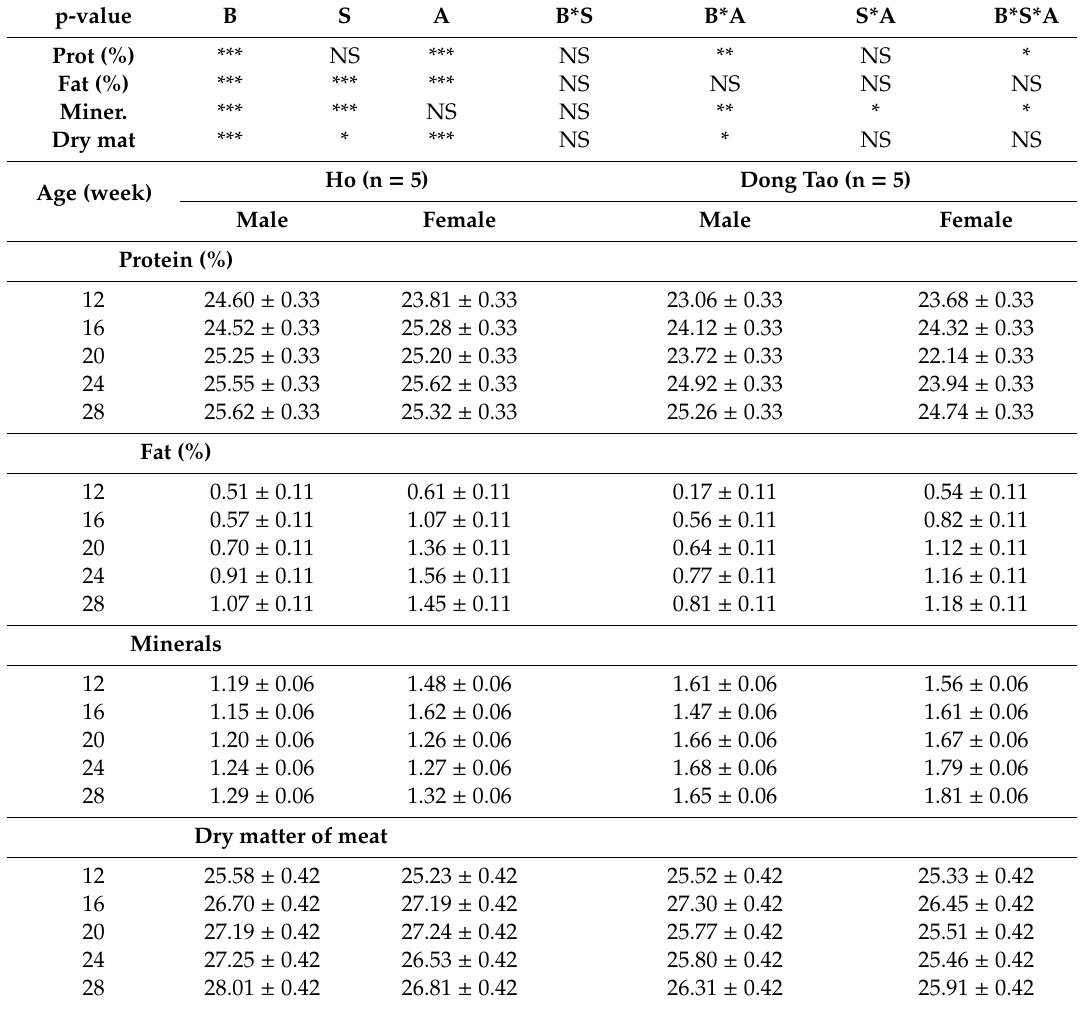
Table 5. Significance of the e ff ects in the statistical model (upper part) and chemical composition of pectoral muscle of Ho and Dong Tao breed (B) by age (A), Sex (S) (LSM ± SE).(lower part).